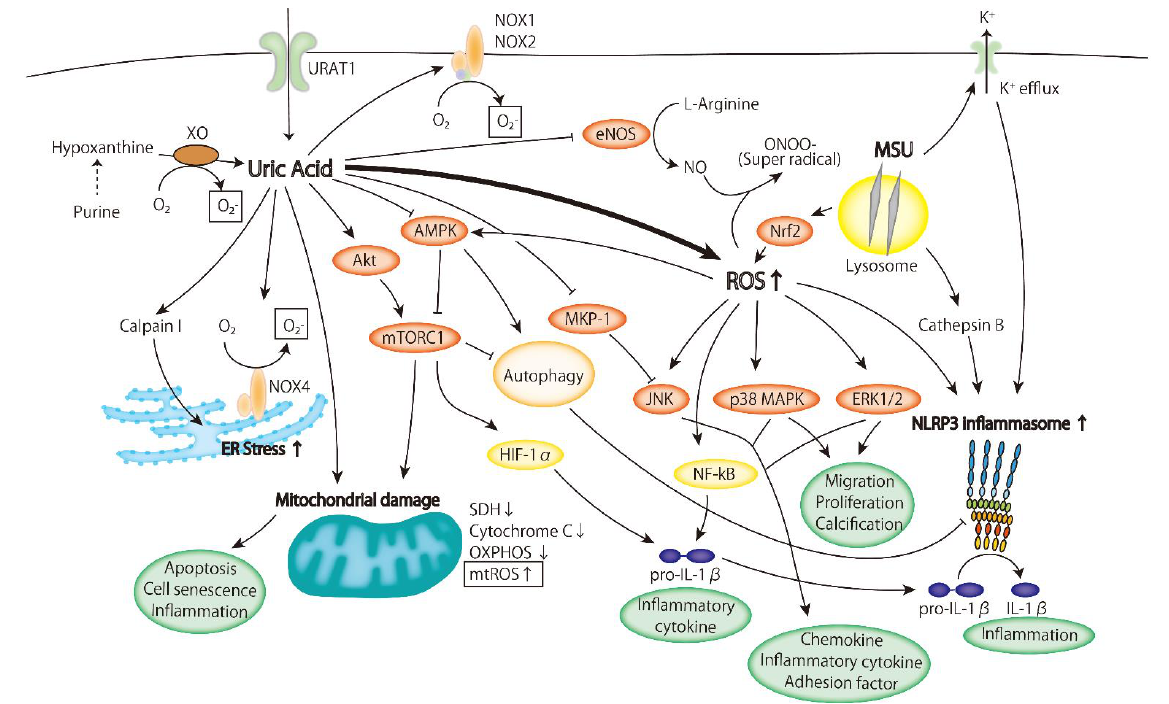
Figure 2. The effect of uric acid on intracellular signaling pathways in the pathogenesis of atherosclerosis. Intracellular uric acid induces reactive oxygen species (ROS) production and activates several inflammatory signaling pathways. XO, xanthine oxidase; NOX, NADPH oxidase; eNOS, endothelial NO synthase; MSU, monosodium urate; AMPK, AMP- activated kinase; Nrf2, Nuclear factor-erythroid 2-related factor 2; mTORC1, mammalian target of rapamycin complex 1; p38 MAPK, p38 mitogen-activated protein kinase; MKP-1, MAPK phosphatase-1; JNK, Jun N-terminal kinase; ERK, extracellular signaling-regulated kinase; HIF- 1α, Hypoxia Inducible Factor 1α; SDH, succinate dehyderogenase; OXPHOS, oxidative phosphorylation; mtROS, mitochondrial ROS.